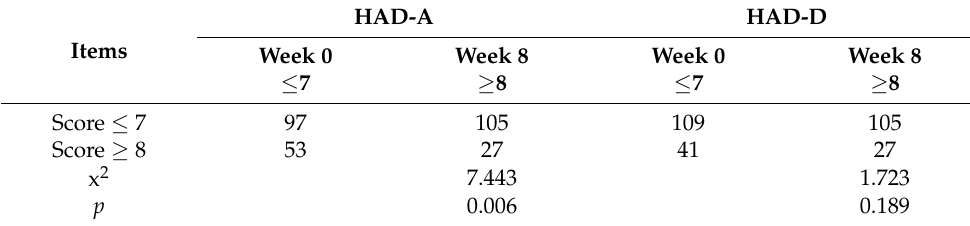
Table 1. Prevalence of anxiety and depression among HIV/AIDS patients.